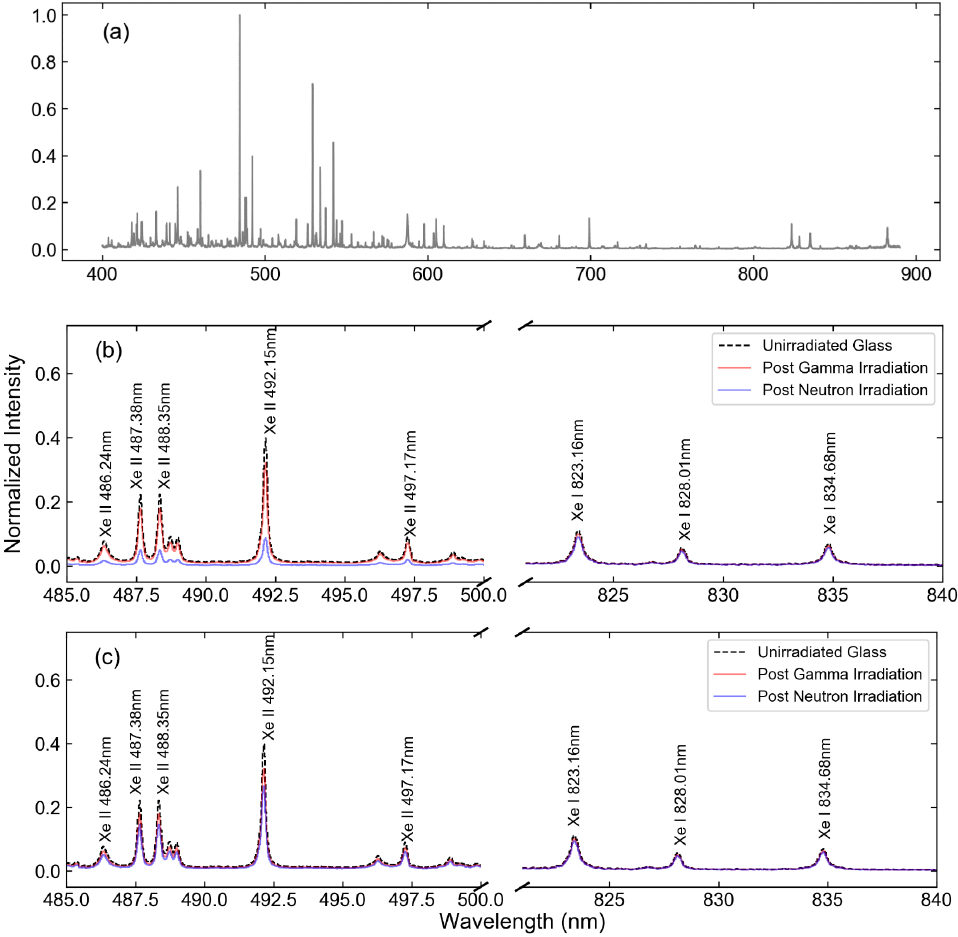
Figure 3. ( a ) Measured 1% Xe in ambient He spectra and spectra adjusted for the changes in absorption in ( b ) Infrasil-302 and ( c ) sapphire windows in the ranges of 485–500 nm and 825–840